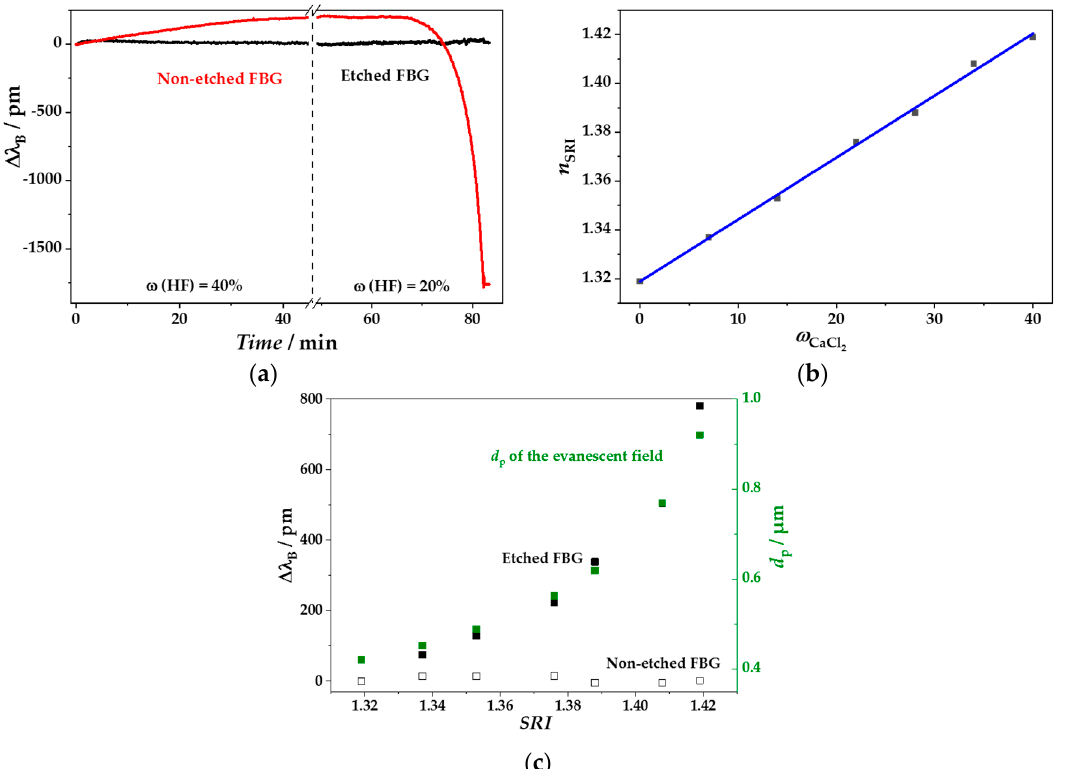
Figure 7. Fiber hydrofluoric acid ( HF) ‐ etching process. ( a ) Δλ B changes during the etching process of a FBG and of a FBG in a non ‐ etching region as reference. ( b ) The corresponding curve between the mass concentrations of CaCl 2 and their refractive index (RI) in water, calculated for λ = 1550 nm. ( c ) Peak maximum shift of the etched FBG (eFBG, black) and non ‐ etched FBG (white) after the etching procedure in relation to surrounding refractive index (SRI) adjusted by different CaCl 2 solutions at a wavelength of λ = 1550 nm. The calculated values of the corresponding penetration depth within the RI range (green) are calculated according to Equation (4).